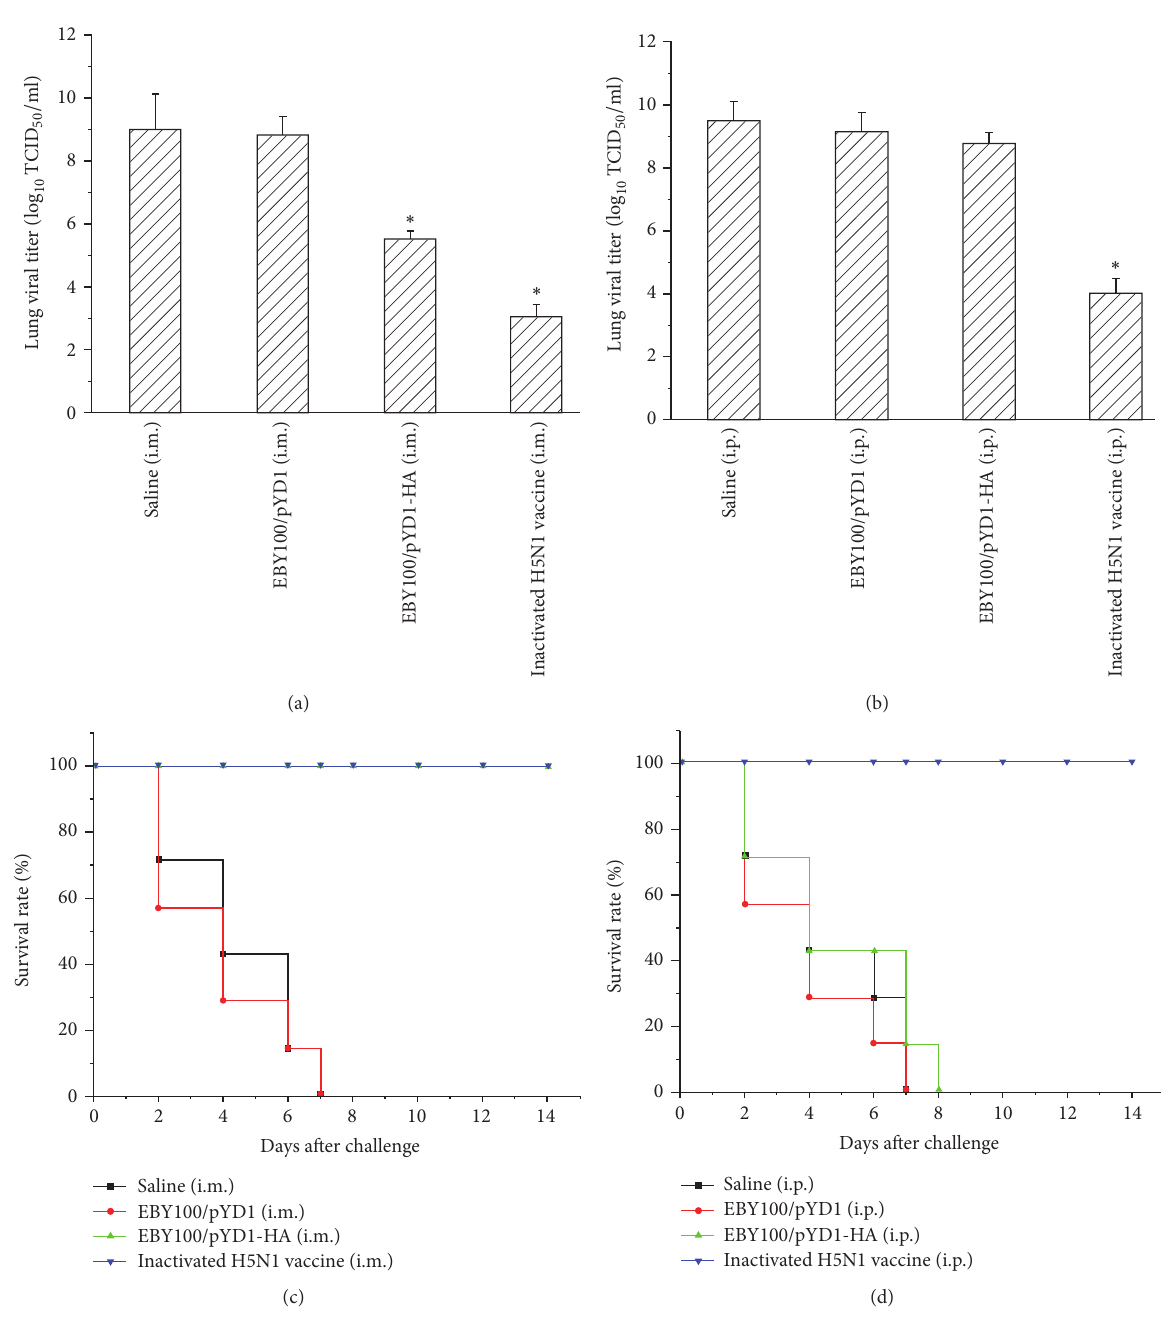
Figure 6: Viral titers and survival rate in vaccinated mice after lethal challenge with homologous H5N1 virus. (a-b) Lung viral titers determined at day 3 after virus challenge ( 𝑛 = 3 of 10 challenged mice). PBS and EBY100/pYD1 injected mice were used as controls. ∗ 𝑝 < 0.05 . (c-d) Survival rate of mice after virus challenge ( 𝑛 = 7 mice/group). Inactivated H5N1 vaccine administrated mice served as positive